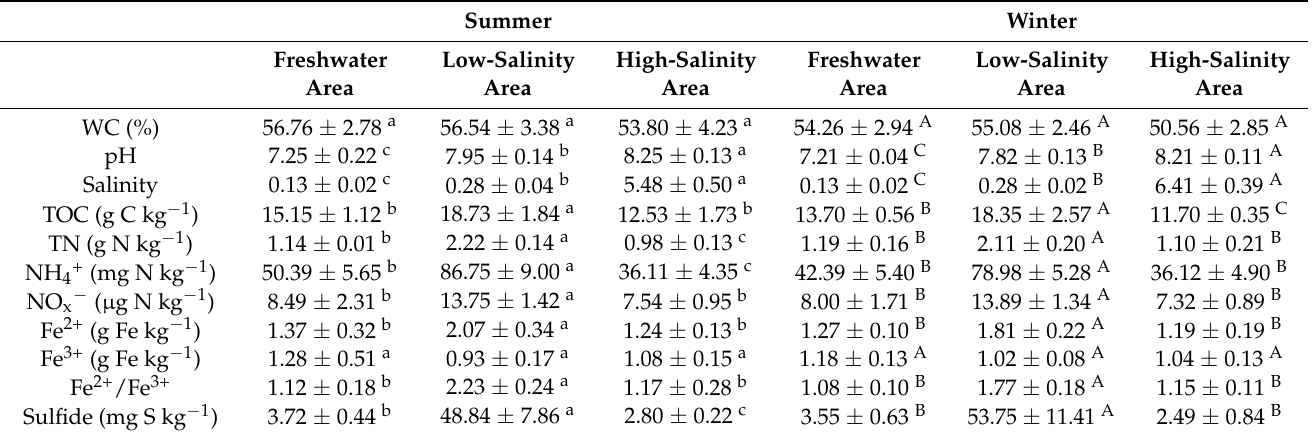
Table 2. Sediment physico-chemical properties in the freshwater, low-salinity and high-salinity area. Summer